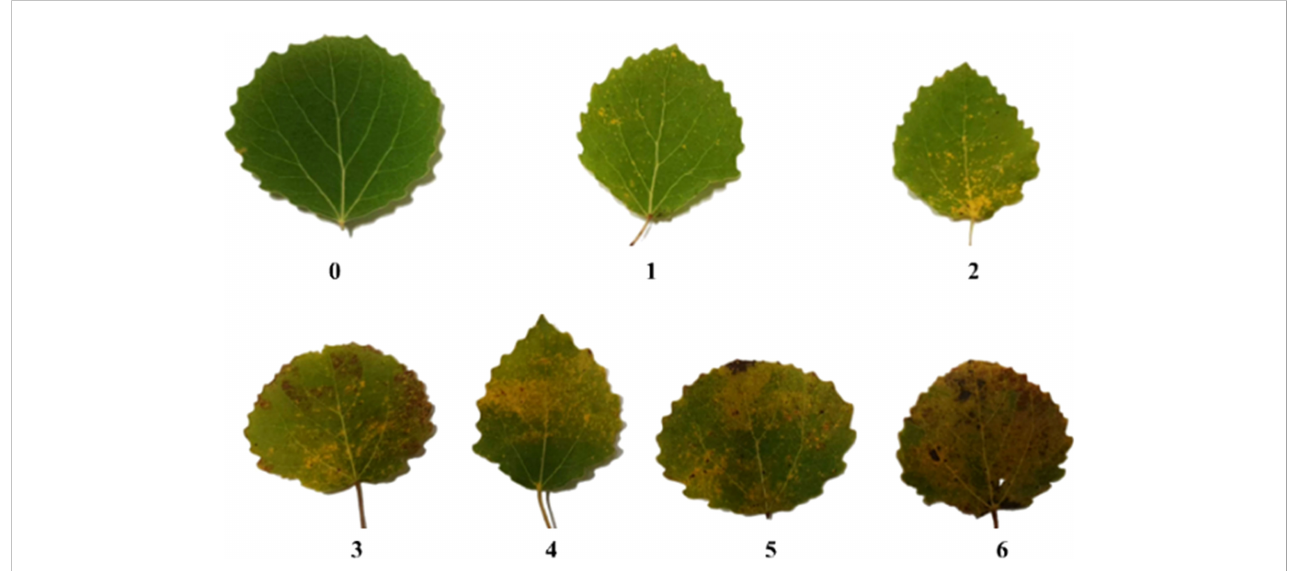
FIGURE 1 Visual scoring of infestation levels based on the density of rust pustules on a leaf. The visual rust score (VRS, Table 1) scale de fi nes seven infestation levels (0 to 6) corresponding to 0, ~10, ~20, ~40, ~60, ~80, and 100% of the leaf area being covered with rust pustules,